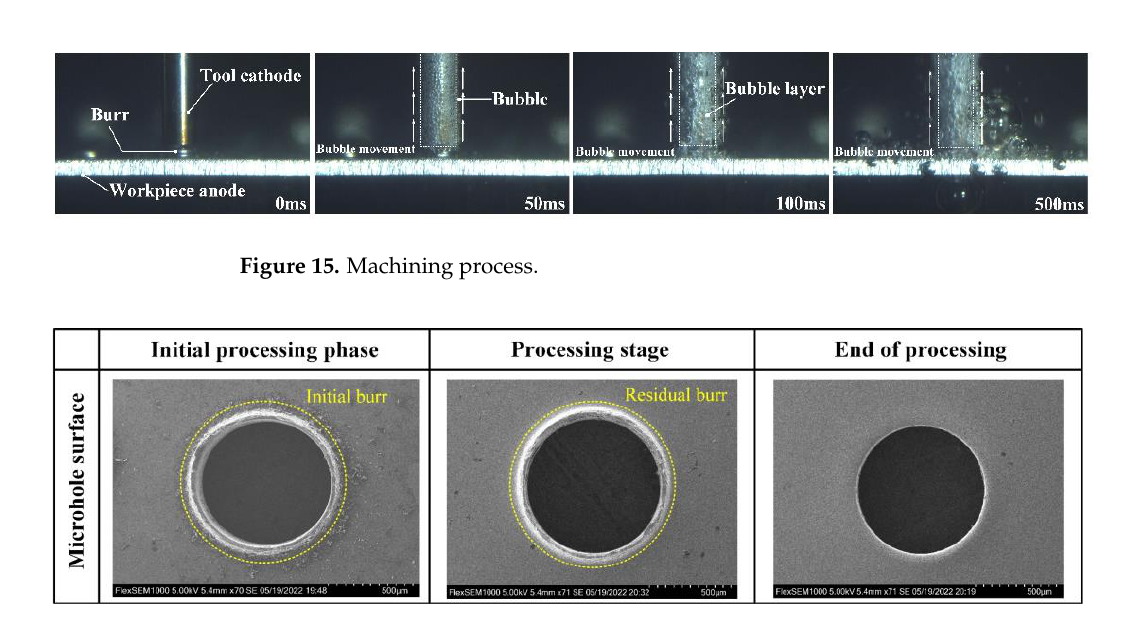
Figure 18. Influence of machining voltage on orifice chamfer. 4.3.2. Influence of Initial Machining Gap Taking U = 4 V, C = 12%, and r 1 = 0.4 mm, the MD-ECD machining effect under dif- ferent initial machining gaps is shown in Figure 19. It can be seen from the figure that the values of L CW and L CH increase with the decrease of the initial machining gap, and the test results are largely consistent with the simulation results. When d = 0.35 mm, the test effect is the best. When d = 0.2 mm, L CW = 98 µm, and L CH = 54 µm are obtained. The chamfer phenomenon is obvious, and the machining gap is too small, which is not conducive to the renewal of electrolyte and the discharge of electrolytic products, thereby reducing the stability of the machining process.